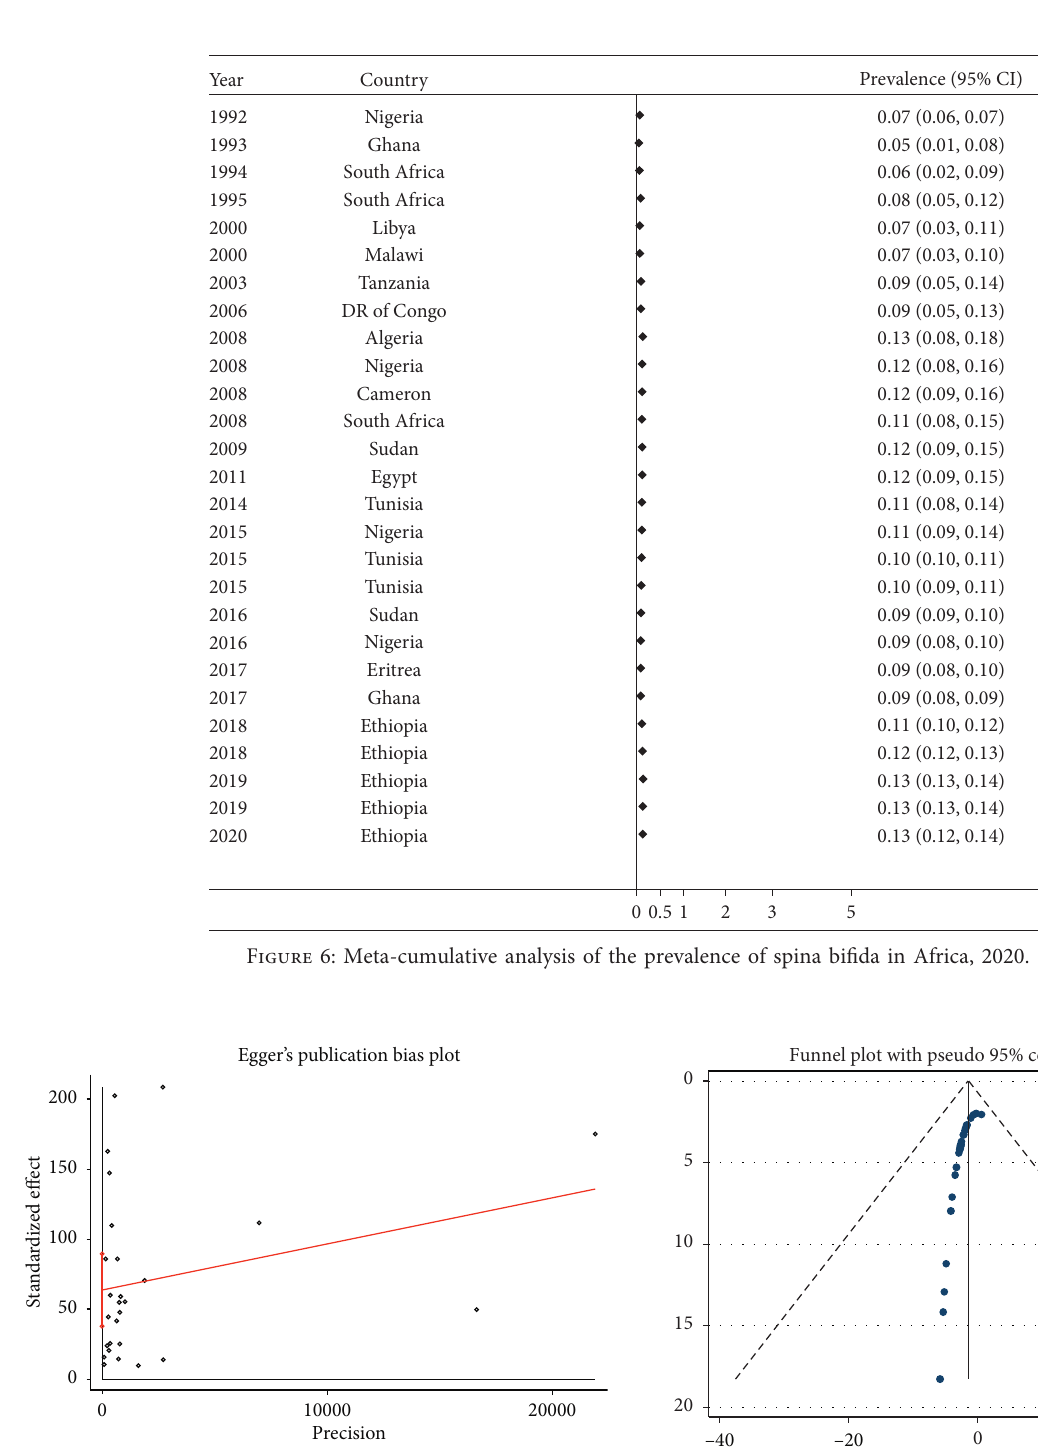
Figure 7: Egger’s publication bias plot, 2020.